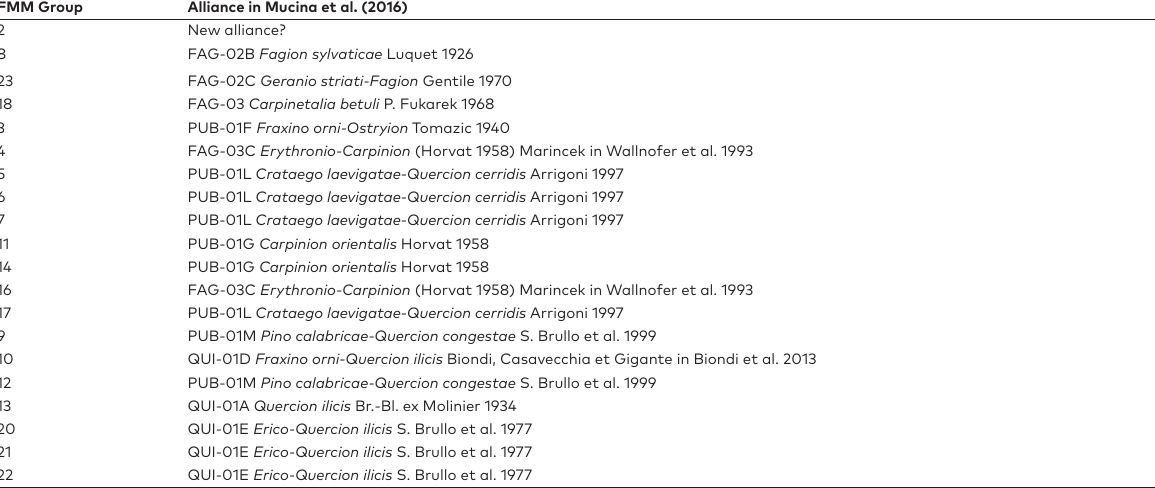
Table 2. Correspondence between the FMM group and the syntaxonomy in Mucina et al. (2016). The alliances are sorted according to an environmental gradient from temperate mesophilous to Mediterranean